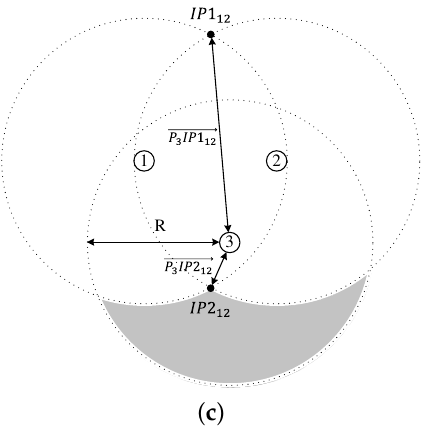
Figure 6. Three cases for additional coverage area calculations. ( a ) Case 1; ( b ) Case 1; ( c ) Case 1.